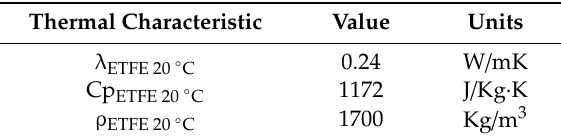
Table 2. Summary of thermal characteristics.